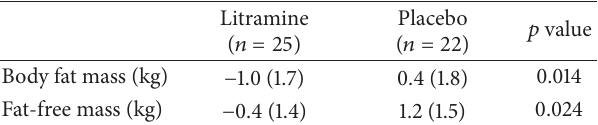
Table 3: Mean changes in body fat mass and fat-free mass in Litramine and placebo groups at week 24.